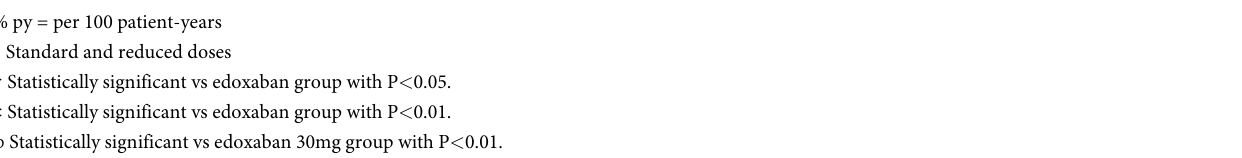
Table 3 shows the hazard ratios for thrombotic and hemorrhagic complications in the edoxaban cohort for each of the baseline and laboratory characteristics. CCI showed a statisti- cally significant association with the first occurrence of a major thrombotic complication, major hemorrhagic complication and all bleeding complications (HR 1.61, 95%CI:1.23–2.09, respectively, for each additional point of CCI). Lower hemoglobin was found to be a significant